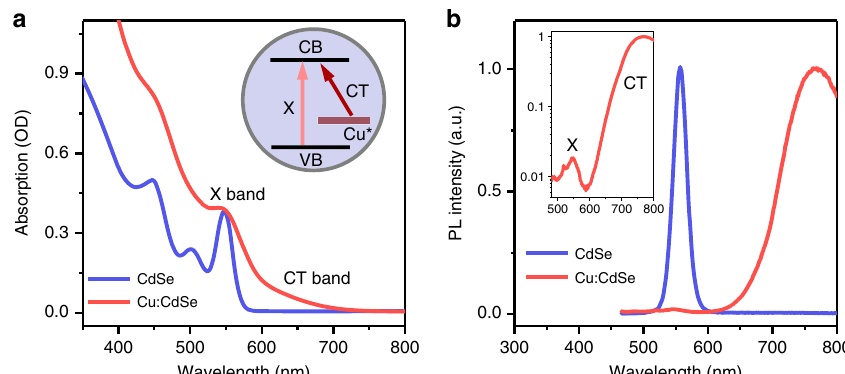
Fig. 2 Optical properties of Cu-doped QDs. a Absorption spectra of CdSe (blue) and Cu:CdSe (red) QDs dispersed in heptane. Exciton (X) and charge- transfer (CT) bands are labeled, which are associated with transitions from the valence band (VB) edge and intragap copper state (Cu*), respectively, to the conduction band (CB) edge (inset). b Photoluminescence (PL) spectra of CdSe (blue) and Cu:CdSe (red) QDs excited at 400 nm. The latter is also plotted in logarithmic scale to show both X and CT band emissions for Cu:CdSe